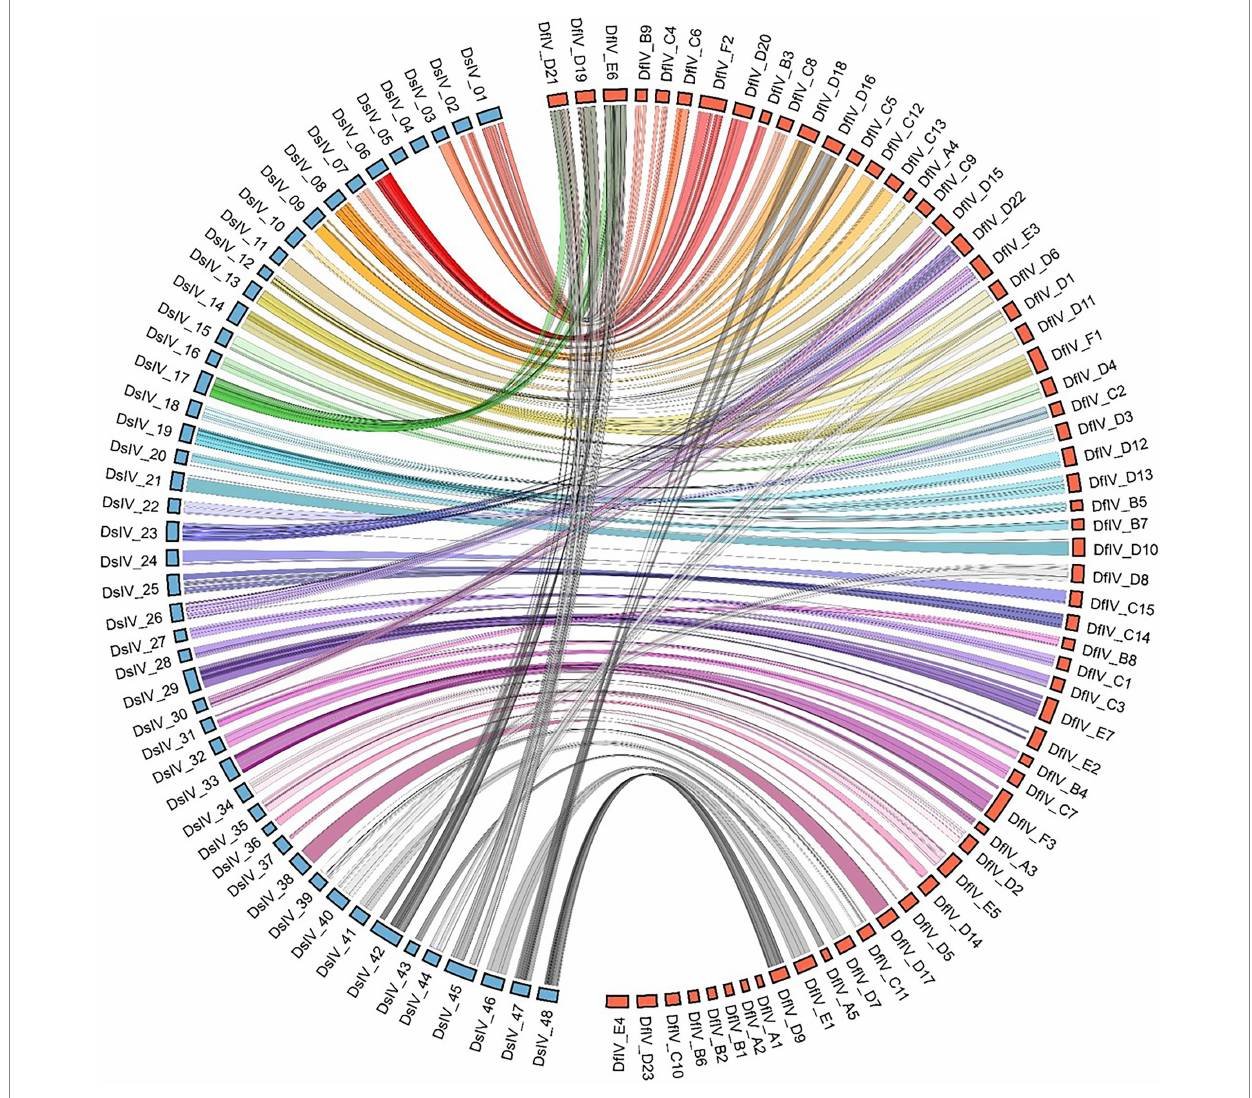
FIGURE 3 Comparison of sequence similarity between 62 genomic segments of DfIV (red) and 48 genomic segments of DsIV (blue) based on BLAST results. Eight specific segments of DfIV and two of DsIV were identified. The DsIV genome was re-sequenced using the AVRDC strain as a template (Taiwan strain, Kim et al., 2015). Comparative analyses revealed a high degree of synteny between loci coding for DfIV and DsIV proviral segments, as well as flanking